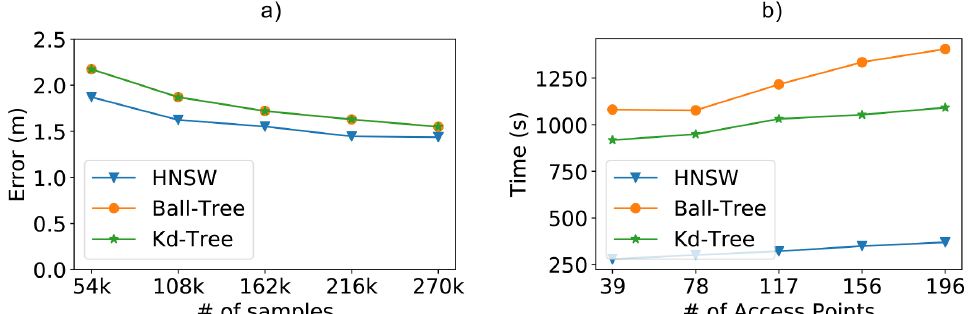
Figure 9. Scalability test results from a dataset containing 196 access points (attributes) and varying the number of samples. ( a ) Positioning error obtained by the experimented methods; ( b ) impact of the number of access points on classify